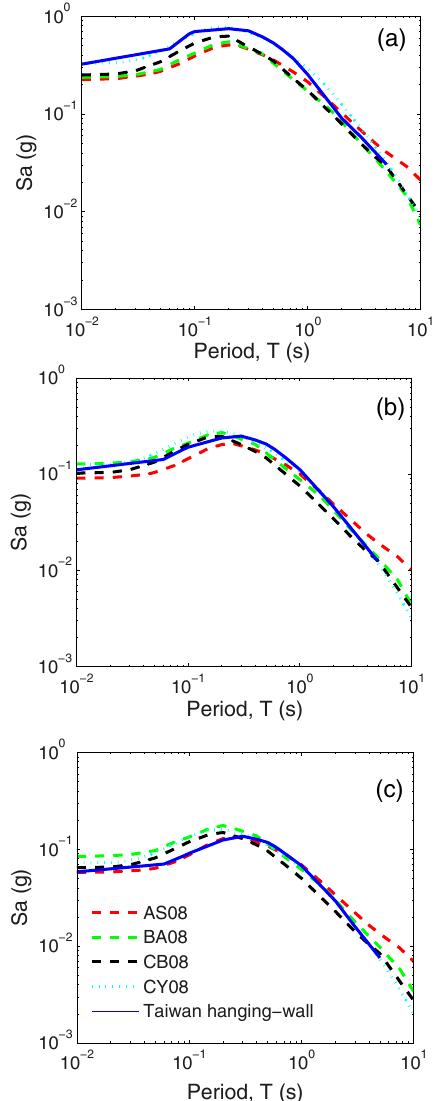
Figure 16. Comparison of spectral acceleration predicted using the local ground-motion prediction equation (GMPE) (Lin et al., 2011) and NGA global GMPEs under three earthquake scenarios: (a) M = 7, R rup = 10km, V s30 = 760ms − 1 ; (b) M = 7, R rup = 30km, V s30 = 760ms − 1 ; (c) M = 7, R rup = 50km, V s30 = 760ms − 1